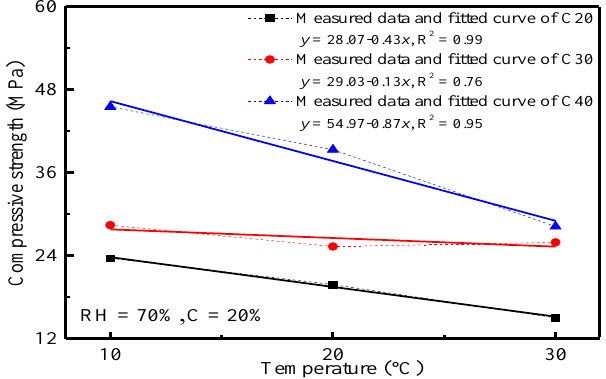
Figure 2. Relation curve between the compressive strength of concrete and temperature.